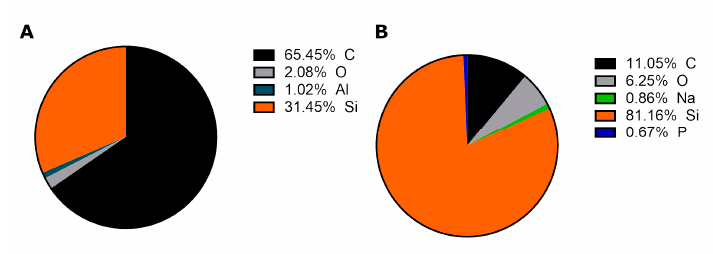
Figure 2. EDS analysis of MWCNTs ( A ) and functionalized MWCNT-Ox ( B ).